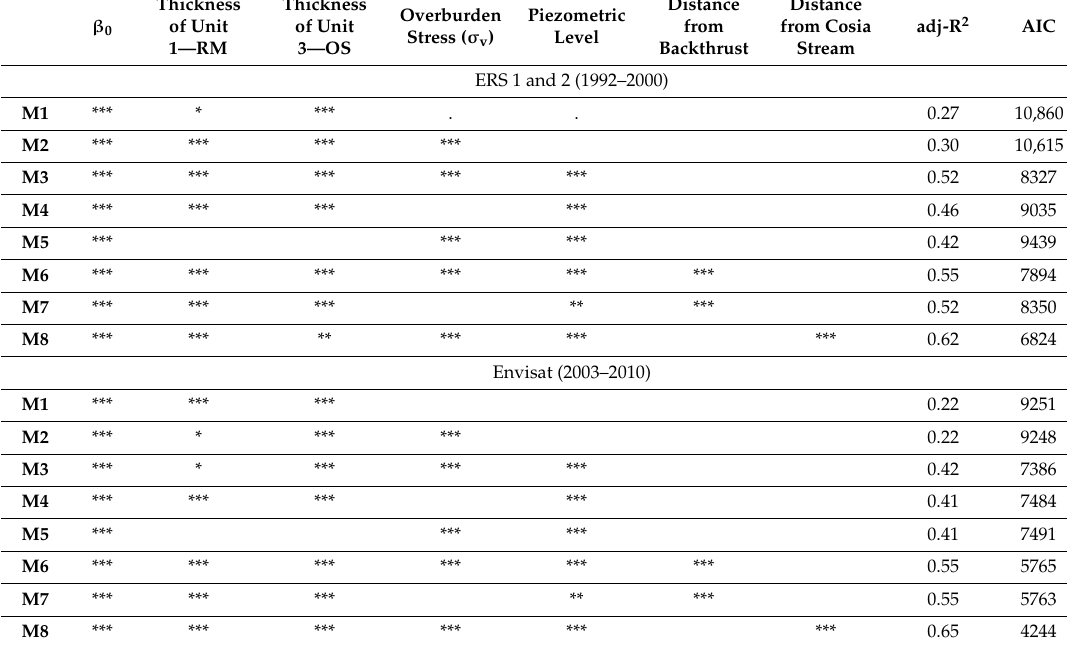
Table A2. Summary of all tested linear regression models (M) using generalized linear model (GLM). β 0 is the parametric component of the predictors (see Equations (3) and (4)). The adjusted R-squared (adj-R 2 ) and Akaike Information Criterion (AIC) values are also listed. Significance codes of p